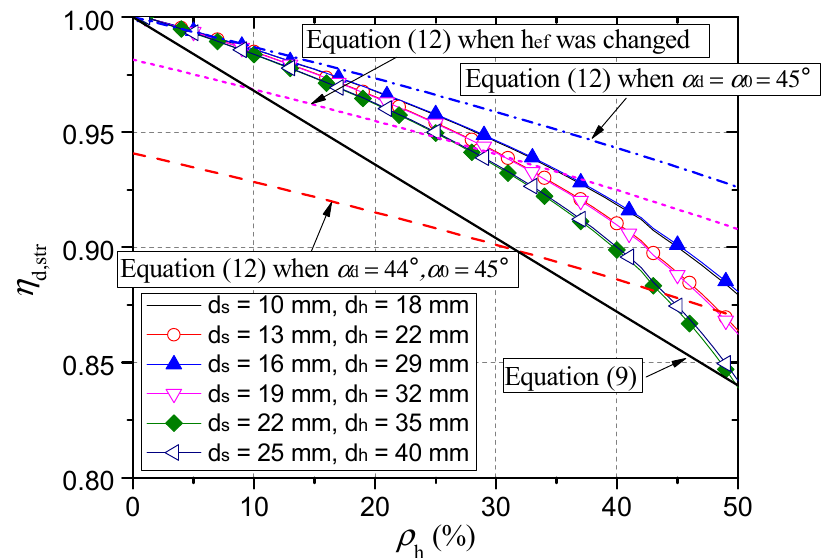
Figure 17. Calculated capacity reduction factors.